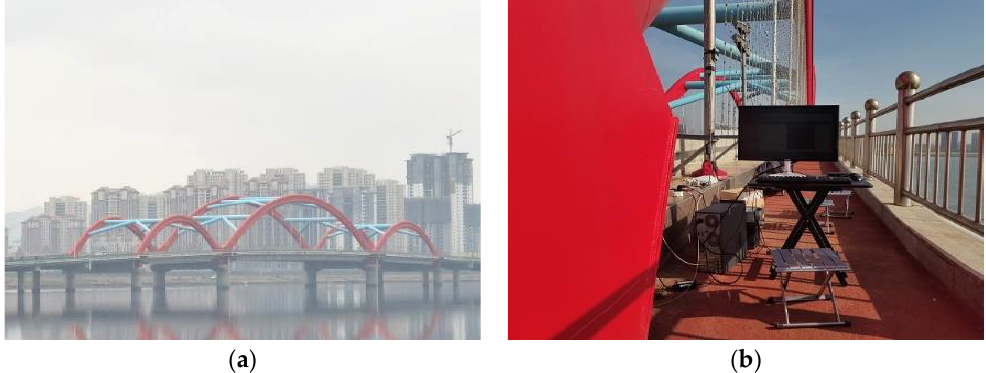
Figure 3. Experiment site: ( a ) panoramic view of Yangma Island Bridge; ( b ) device connection.